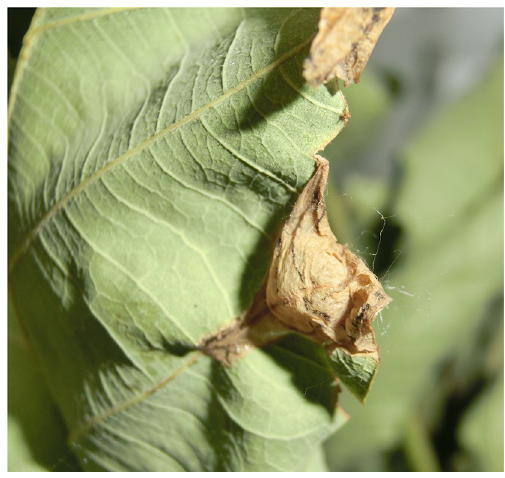
Figure 6. Blister-like blotch (pupa chamber) on the edge of an oak leaf.